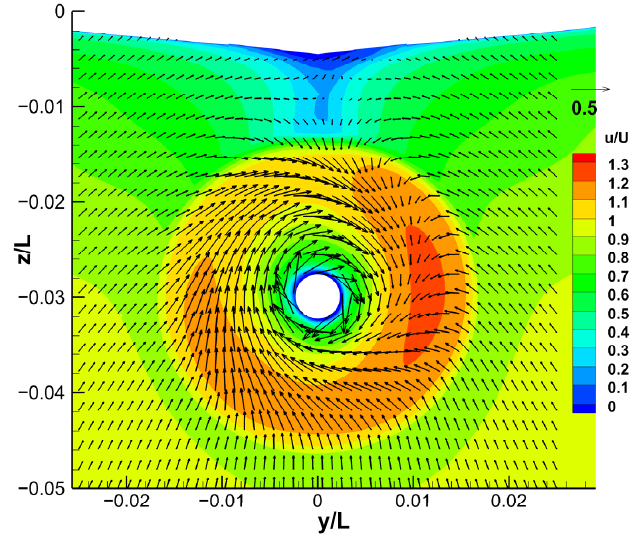
Figure 19. Wake field after propeller ( x/L = 0.985) for the average model.